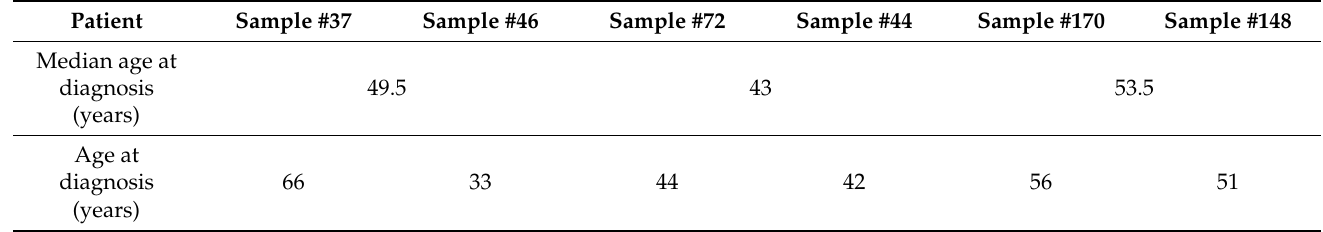
Table 1. Clinical characteristics of patients and samples used in this